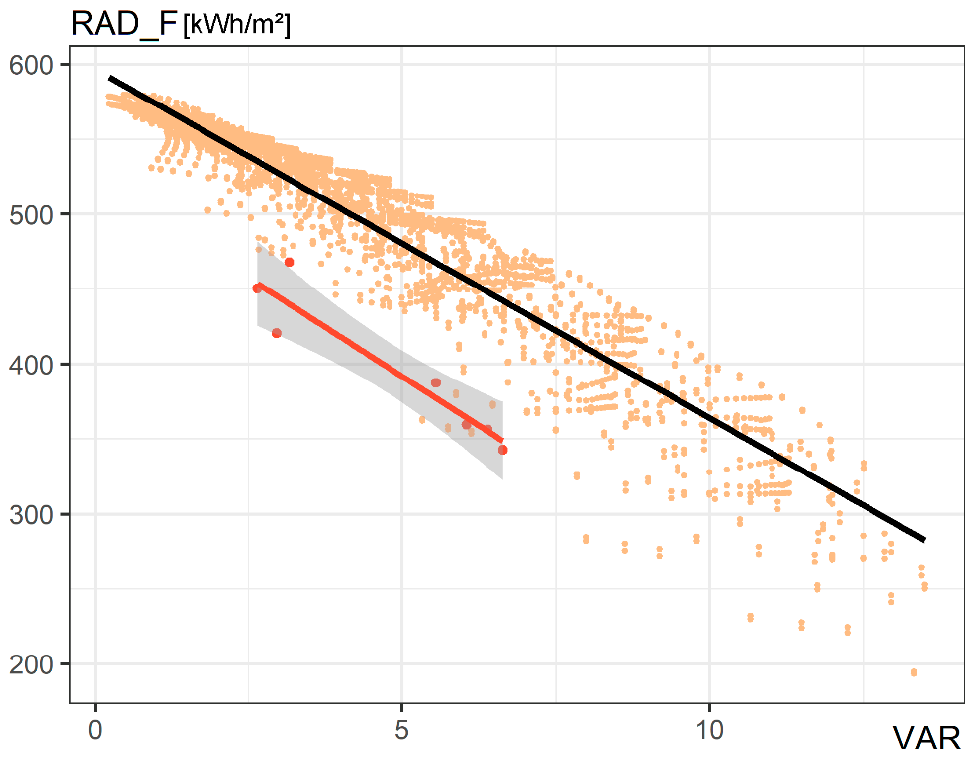
Figure 22. Linear regression function of metrics VAR and RAD_F based on neighbourhood iterations (black line) and case studies (red line), including the 95% CI for the case studies regression line indicated by the grey area.